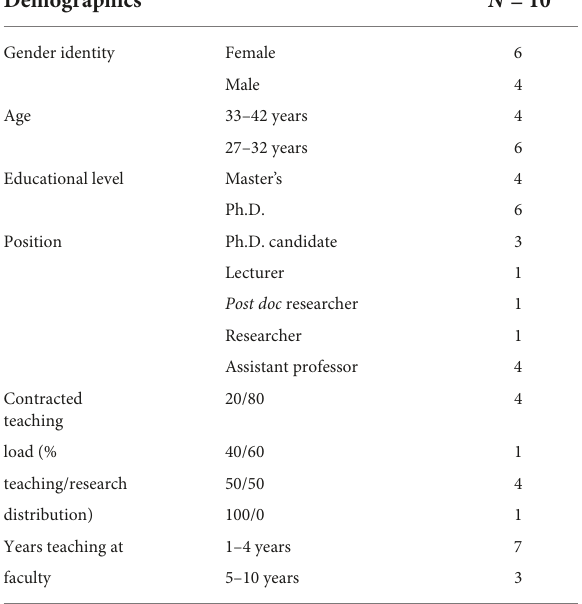
TABLE 1 Overview of interviewees’